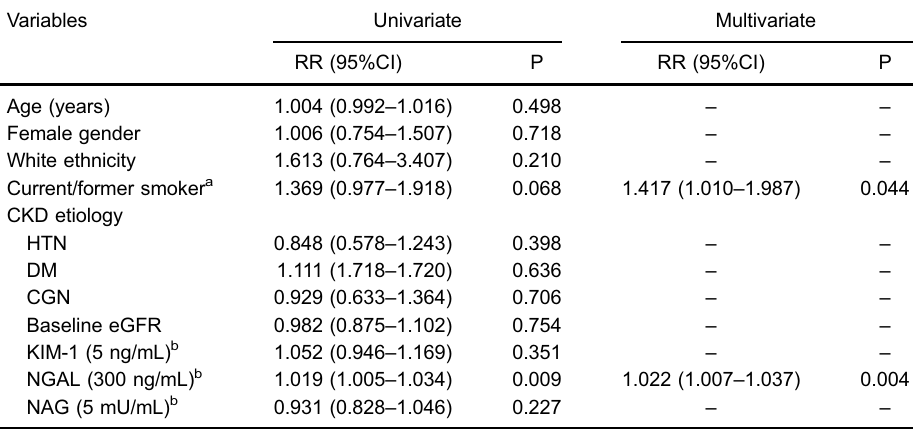
Table 6. Poisson regression analysis to determine factors independently associated with adverse outcomes (progression of CKD stage, ESKD, or death) in patients not on dialysis at baseline. Variables